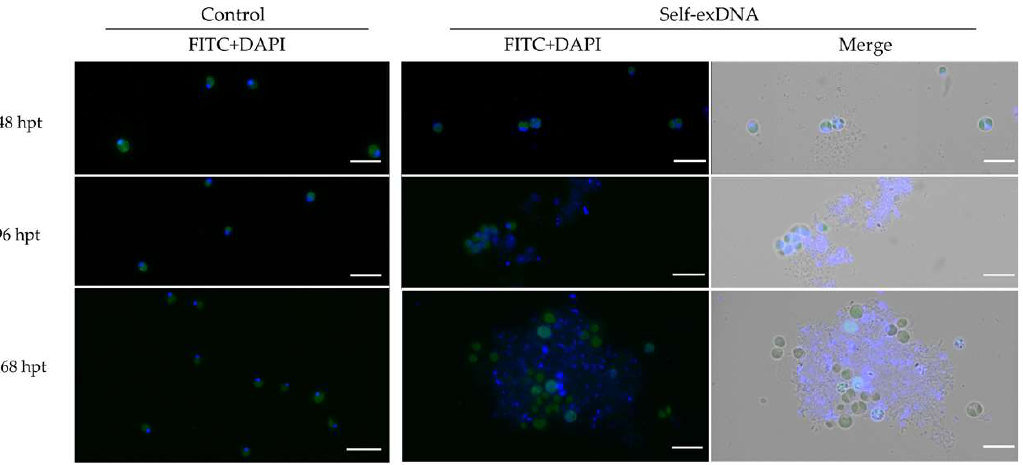
Figure 4. Fluorescence analysis of C . reinhardtii cells after treatment with self-exDNA at 30 ng/µL: focus on cellular aggregates formation. Cellular aggregates were analyzed using DAPI staining. Microscope: Leica DM6000B, Wetzlar, Germany; Ex/Em: 358/460 nm; Objective: HC PL APO 63 × 1.40 Oil, scale bar = 10 µ m.